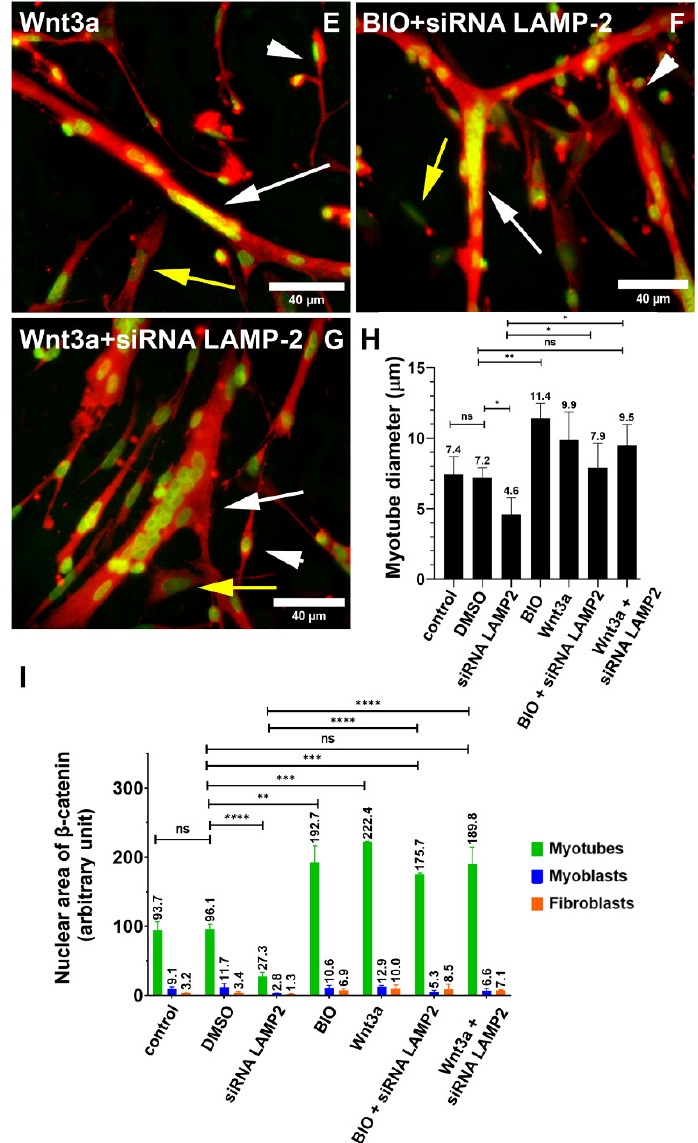
Figure 6. Activation of the Wnt/beta-catenin pathway can revert the effects of the downregulation of LAMP2 in chick muscle cells. Chick myogenic cells were grown for 24 h and either transfected with siRNA against LAMP2 or treated with BIO or Wnt3a. Cells were double-labeled with antibodies against beta-catenin (red, A – G ) and the nuclear dye NucSpot (green, A – G ). White arrows represent myotubes (Myot), white arrowheads represent myoblasts (Myob), and yellow arrows represent fibrob- lasts (Fib). Myotube diameter decreased after the downregulation of LAMP2, whereas both Wnt3a and BIO were able to revert this effect ( H ). Beta-catenin labeling was found in the cytoplasm in un- treated (control) cells and in cultures transfected with siRNA against eGFP and against LAMP2 ( A – G ). Note the decrease in the nuclear localization of beta-catenin in myotubes after the downregulation of LAMP2, which was reverted by BIO and Wnt3a ( I ). Scale bars in ( A – G ) = 40 µ m. Quantifications were performed from at least fifty randomly chosen microscopic fields collected from three independent experiments. One-way ANOVA followed by Tukey’s multiple comparison test, * p < 0.05, ** p < 0.01, *** p < 0.001, **** p < 0.0001. Error bars denote mean ± SEM. n.s. =